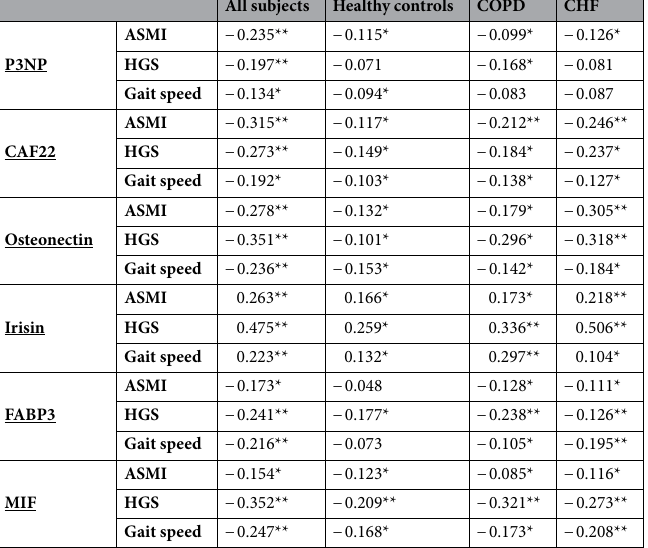
Table 2. Correlations coefficients of circulating biomarkers with indexes of sarcopenia including ASMI, HGS and gait speed in healthy controls and patients with COPD and CHF (N = 83–87 per group). * p < 0.05, ** p < 0.001. (P3NP; amino-terminal of type III pro-collagen peptide, CAF22; C-terminal Agrin fragment-22, FABP3; fatty acid-binding protein 3, MIF; Macrophage migration inhibitory factor).